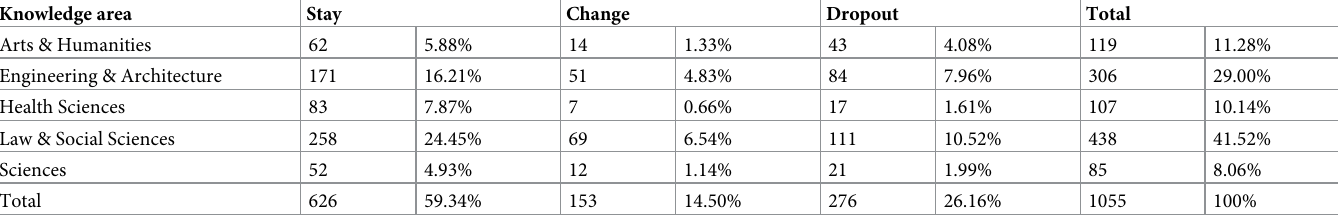
Table 1. Sample distribution by knowledge